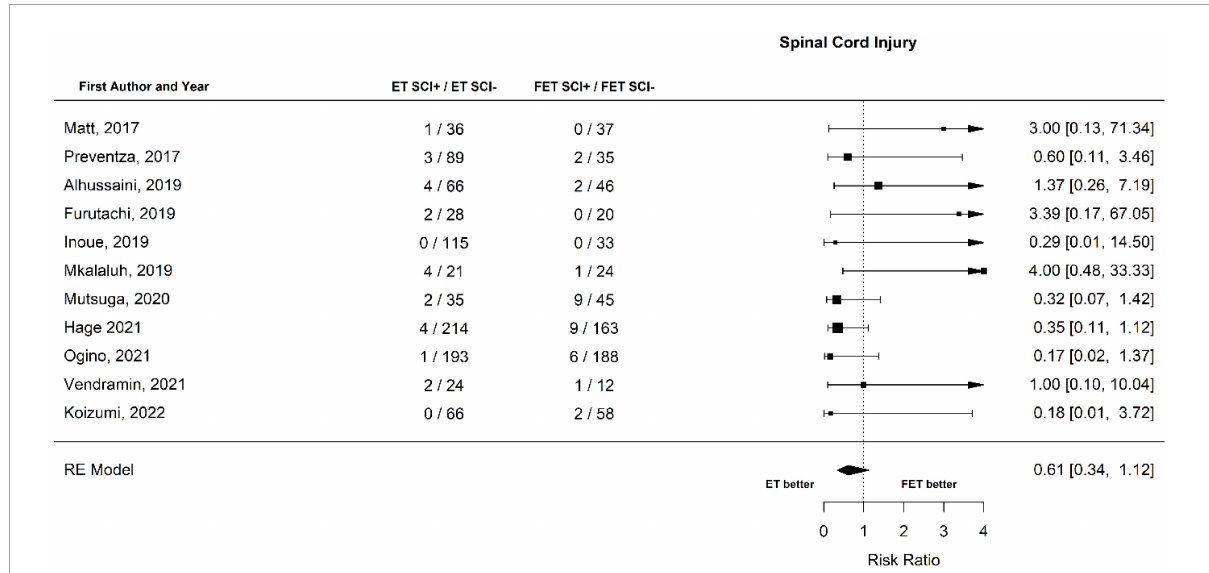
FIGURE11 Relative risk of spinal cord injury (SCI) and hemiplegia/paraplegia in patients undergoing aortic interventions with conventional elephant trunk (ET) vs. frozen elephant trunk (FET). Data only from studies published between 2017 and 2021. Forest plot. ET vs. FET: p = 0.113.